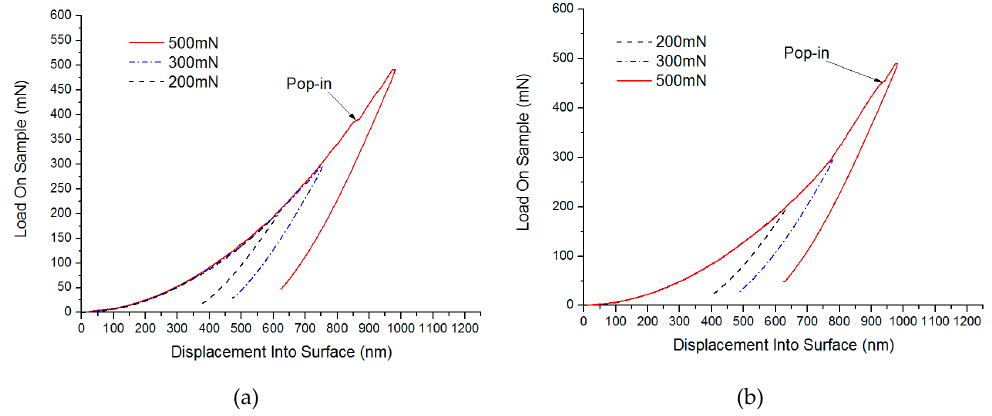
Figure 5. Test results of Single crystal 6H-SiC substrates under large loads ( a ) Load and depth curve in large loads of C face and ( b ) Load and depth curve in large loads of Si face.